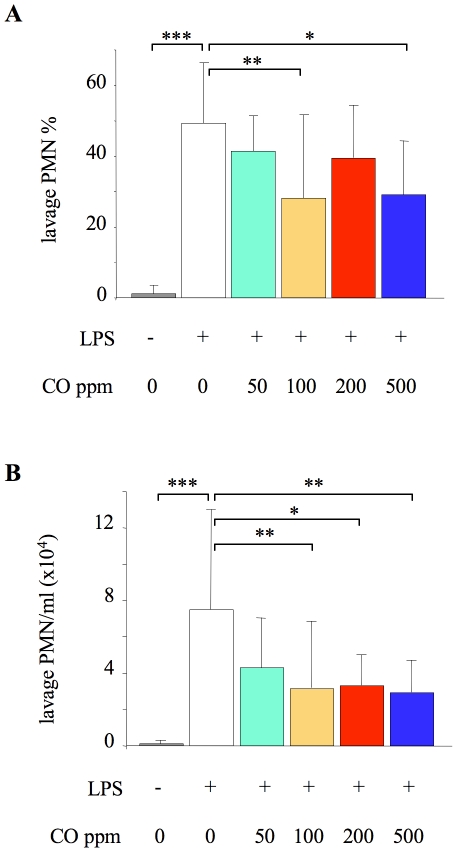
Alveolar neutrophil recruitment 24 hours after LPS.Impact of carbon monoxide (CO) exposure on neutrophil (PMN) percentage (A) and number/ml (B) in lung lavage fluid of untreated animals (no LPS or CO), or mice treated with 10 ng intratracheal LPS. LPS-challenged mice were exposed to either 0 (air), 50, 100, 200, or 500 ppm CO for 24 hours both before and after LPS. *p<0.05, **p<0.01 ***p<0.001 vs LPS +0 ppm CO; n = 19 for LPS +0 ppm CO, and 8–12 for all other groups (numbers are higher in the LPS+0 ppm CO group because, as our primary control, we ran 1–2 of these animals alongside the experiments for each of the other groups).